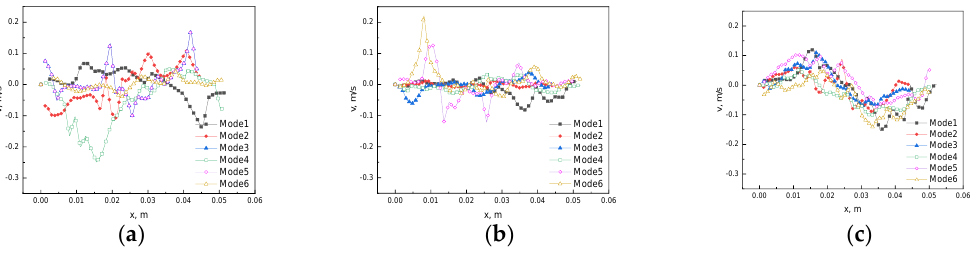
Figure 8. Horizontal component of velocity at 1 mm below liquid surface in three physical forms of hydraulic jump (casting speed 2.4 m/min). ( a ) CHJ; ( b ) HJT; ( c ) SLL.